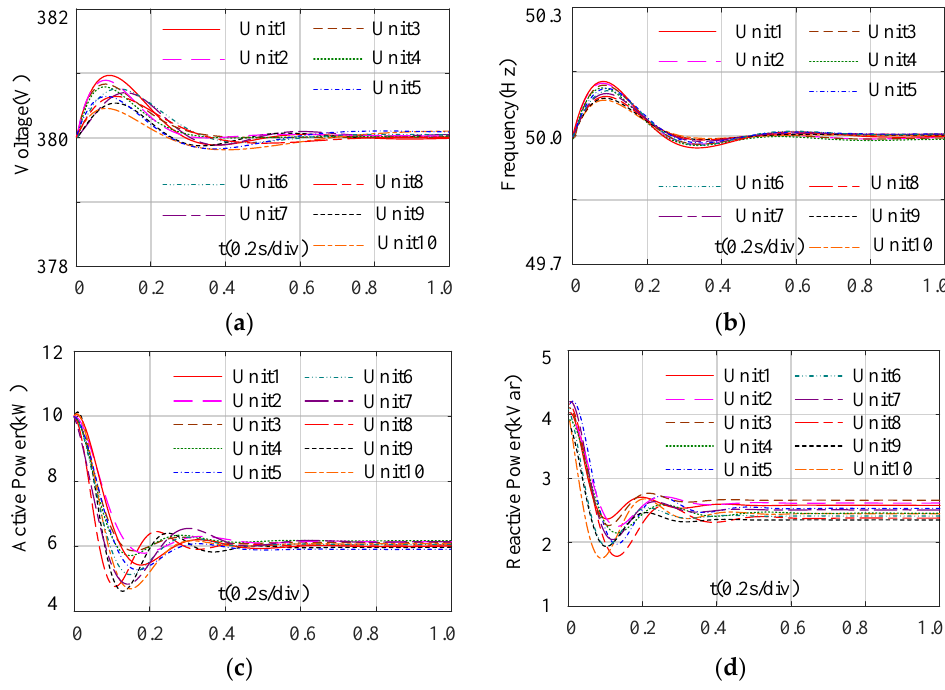
Figure 10. The simulation results with the control strategy in [25] under load change at t = 0 s. ( a )voltage amplitude;( b ) frequency;( c ) active power;( d ) reactive power.